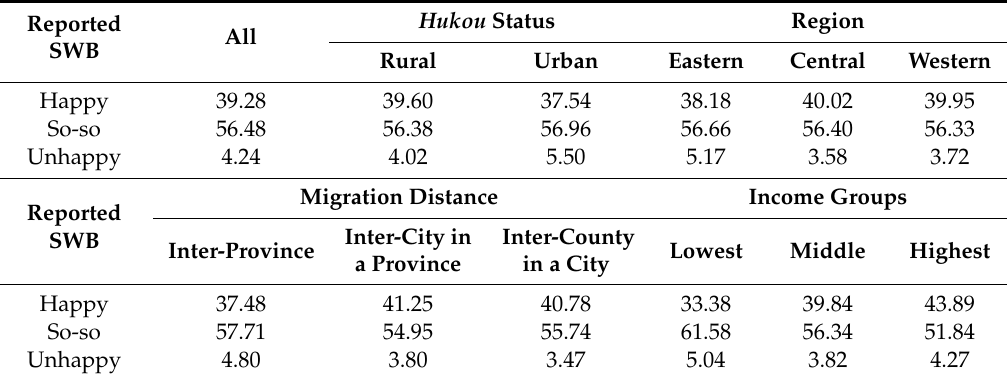
Table 2. SWB of migrants in